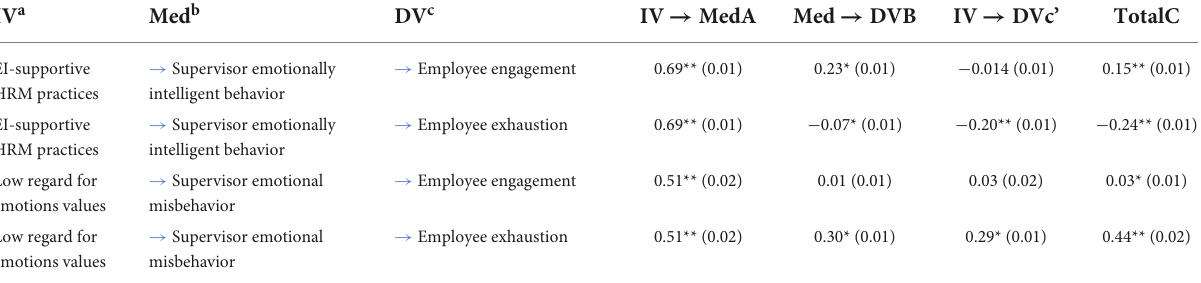
TABLE 6 Mediating effect of supervisor emotionally intelligent behavior and supervisor emotional misbehavior on the relationships between EI-supportive HRM practices and low regard for emotions values and employee engagement and